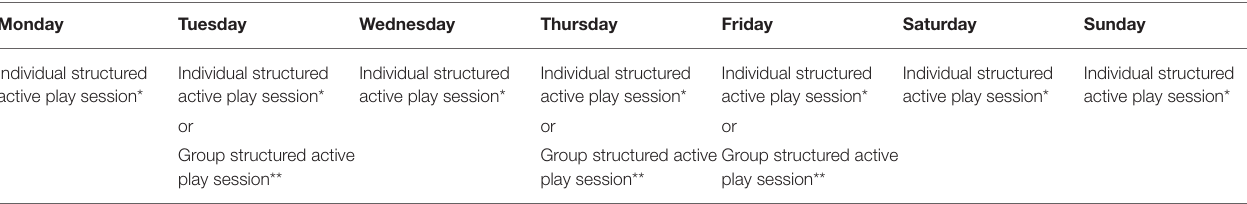
TABLE 1 | Example of a weekly schedule of structured active play for preschoolers with cancer, during